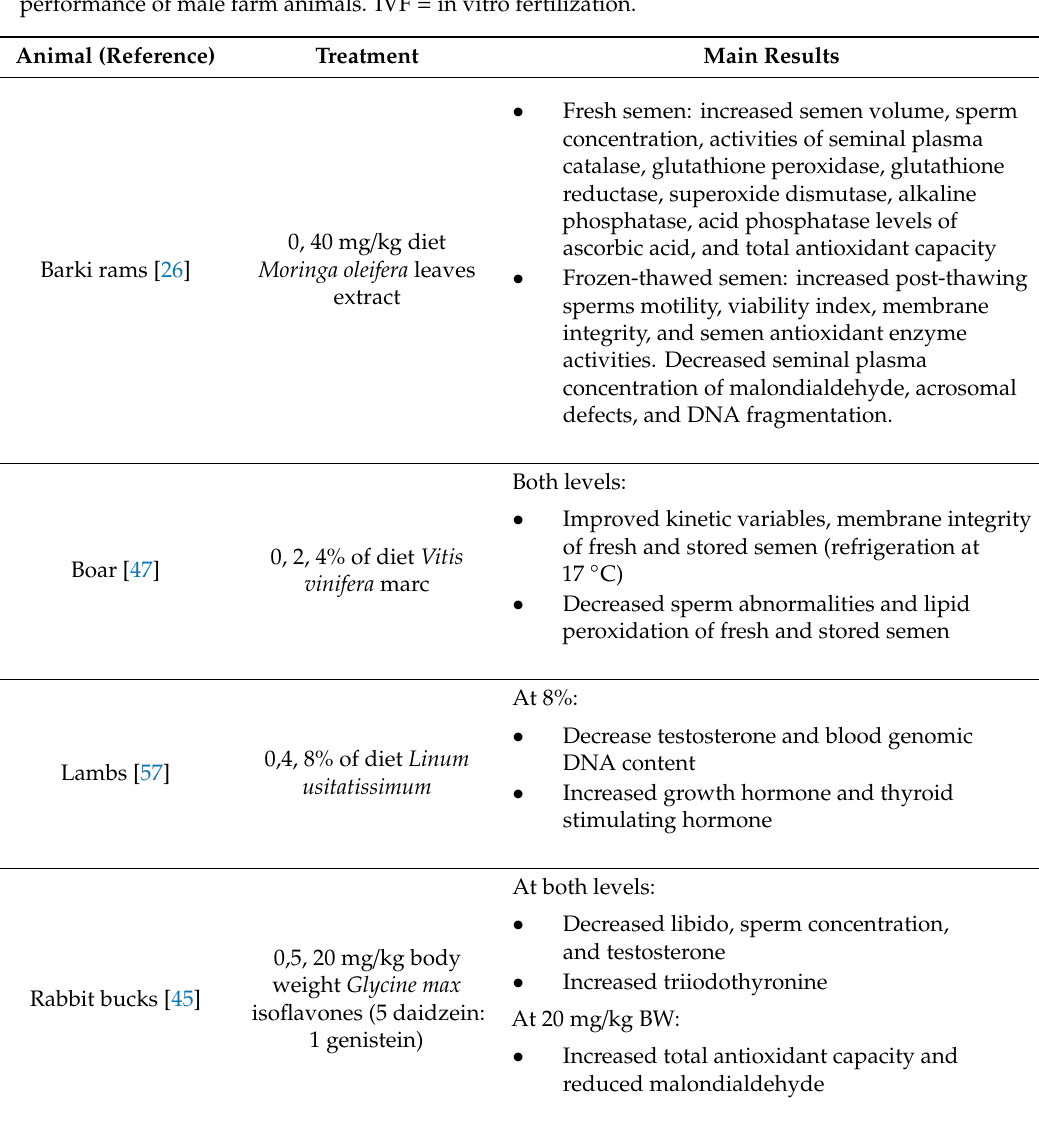
Table 2. Summary of some recent in vivo studies on the e ff ects of polyphenols on reproductive performance of male farm animals. IVF = in vitro